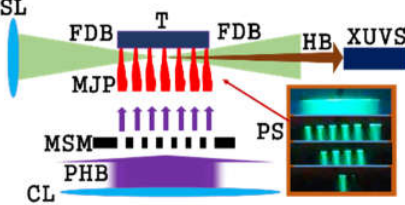
Figure 1. Experimental setup for high-order harmonic generation (HHG) in MJP. CL, cylindrical lens; PHB, picosecond heating beam; MSM, multi-slit mask; MJP, multi-jet plasma; T, target; SL, spherical lens; FDB, femtosecond driving beam; HB, harmonic beam; XUVS, extreme ultraviolet spectrometer. Inset: The extended, six-, four-, and single-jet plasma images are shown from the top to bottom. PS, plasma shapes.